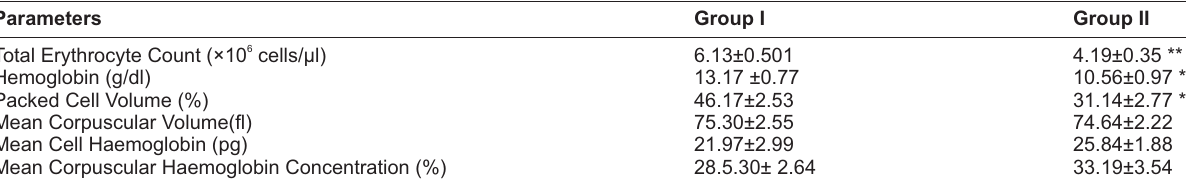
Table-4: Biochemical changes in dogs with kidney dysfunction Parameters Creatinine (mg/dl)